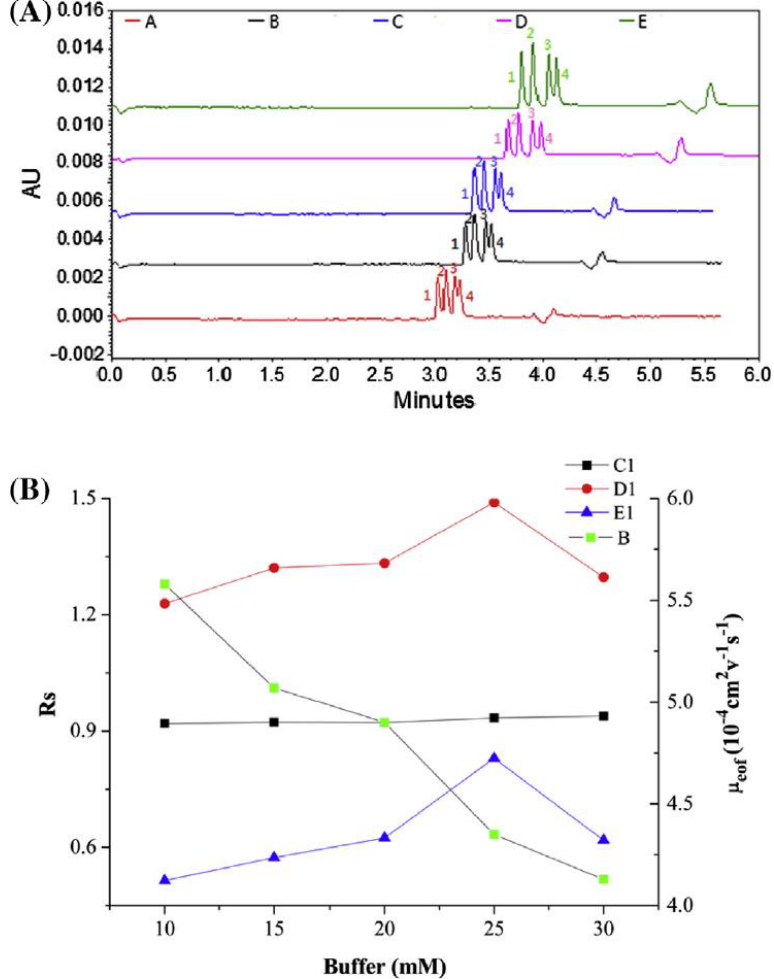
Figure 2. Effect of ammonium acetate amount ( A ), the separation phenomenon, and ( B ) resolution factors of the stereoisomers: cinchonidine (1), quinine (2), cinchonine (3), quinidine (4). (A) 10 mM, (B) 15 mM, (C) 20 mM, (D) 25 mM, (E) 30 mM. (C1)—cinchonidine/quinine, (D1)—quinine/cinchonine, (E1)—cinchonine/quinidine), and (B)— µ eof of the diastereomers. Reprinted with permission from Ref. [38].